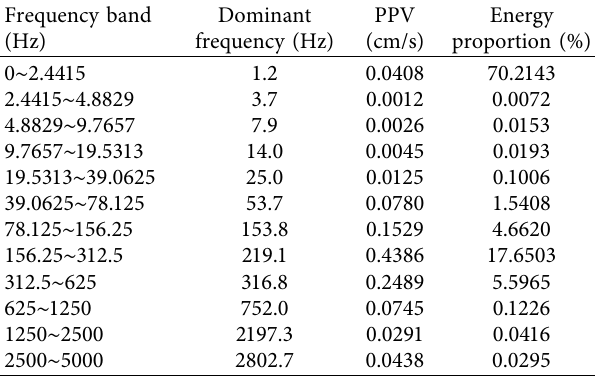
Table 8: Dominant frequency, PPV, and energy proportion of each subfrequency band at measuring point 6 in the medium zone.